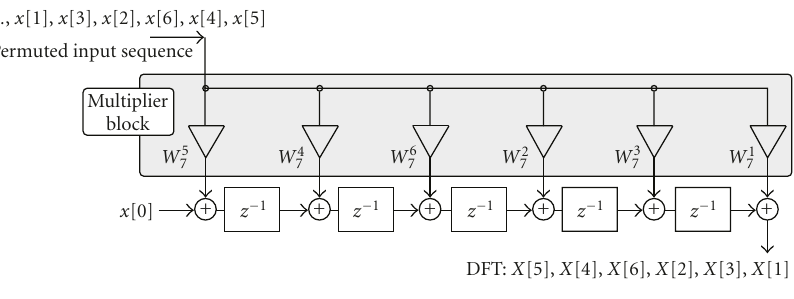
Figure 1: Length p = 7 Rader prime factor DFT